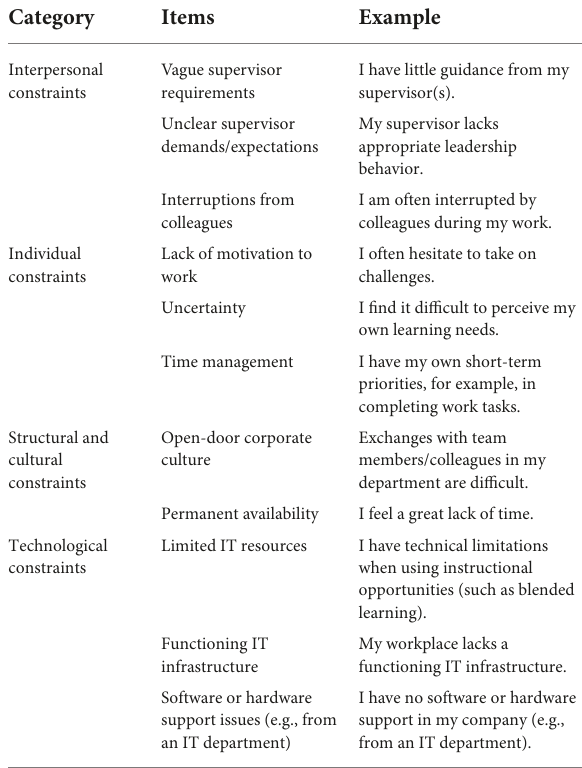
TABLE 2 Categories items and related examples (Anselmann, in